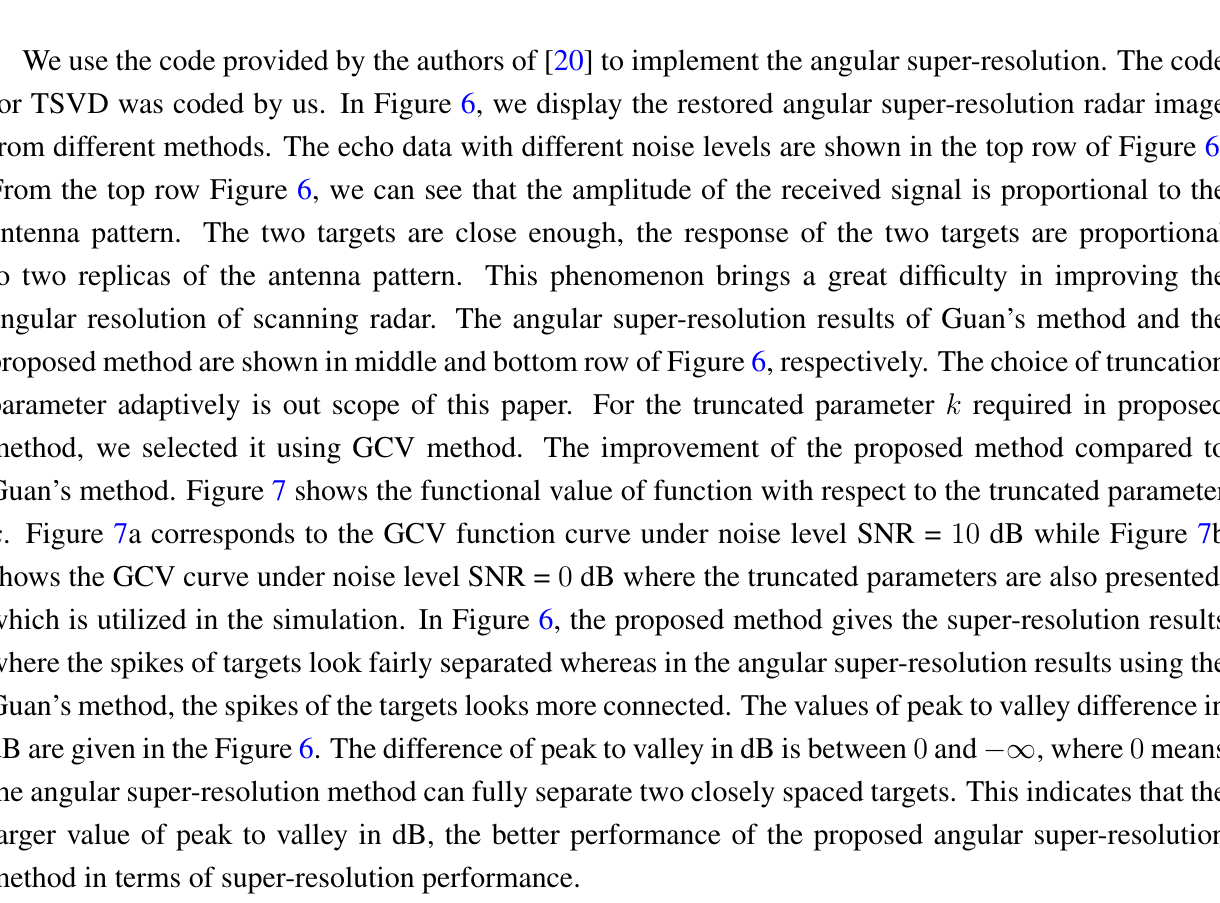
Figure 3. The definition of peak to valley point difference in dB. Figure 5. The definition of peak to valley point difference in dB